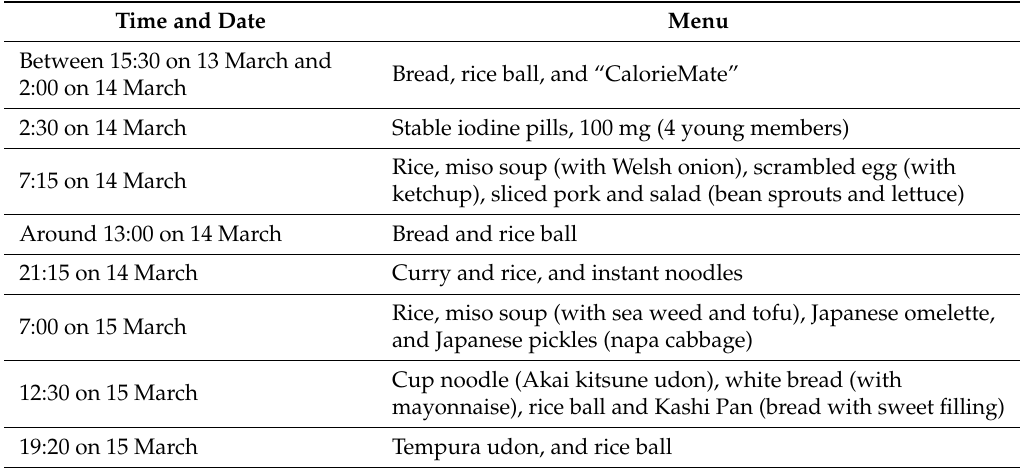
Table 6. The content of meals during dispatch, including the ingestion time of the stable iodine